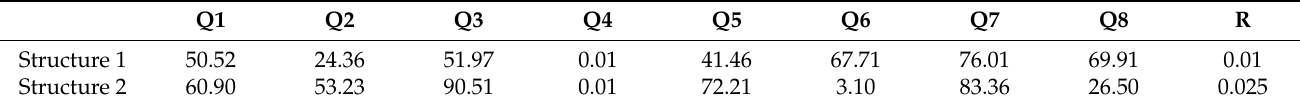
Table 3. Optimal parameters for structure 1 and structure 2.